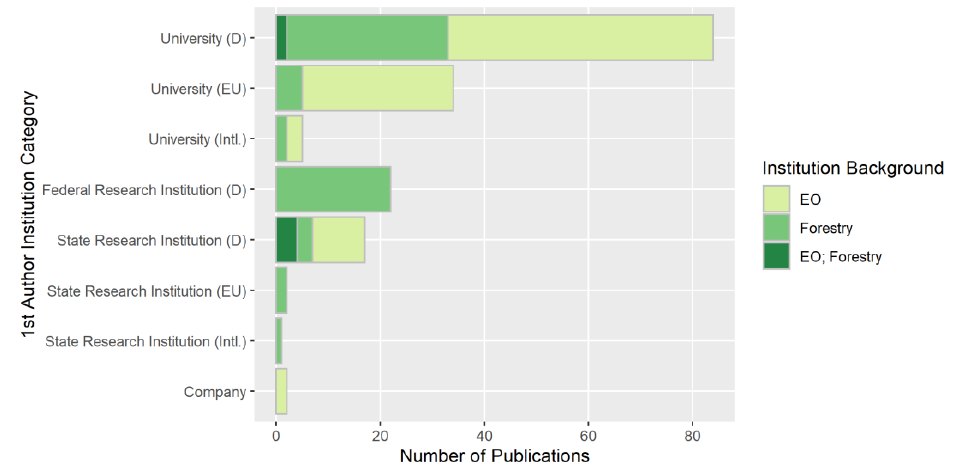
Figure 8. Number of studies by research institution.